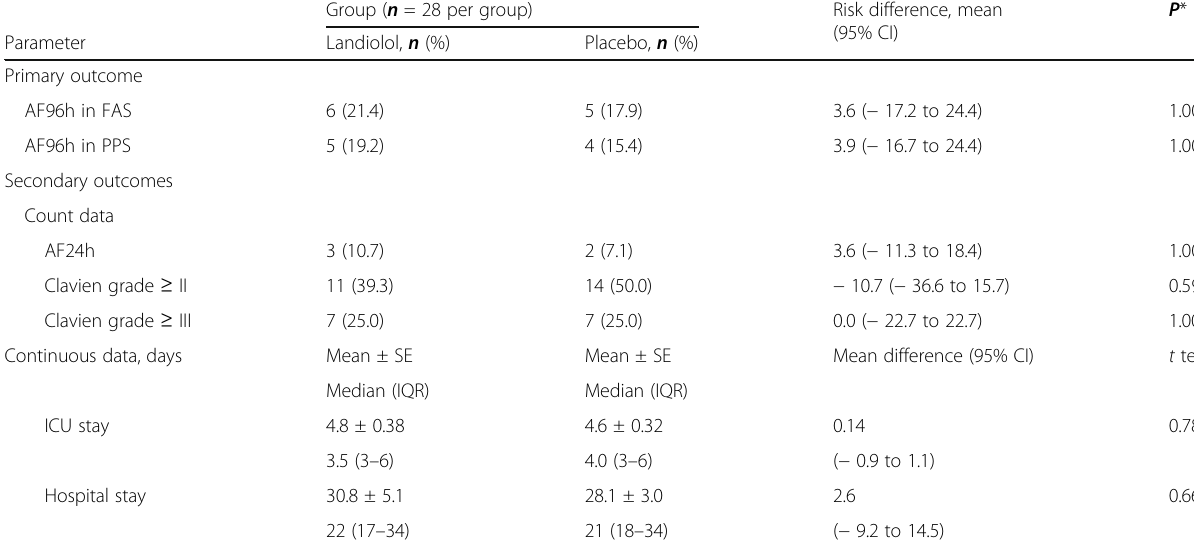
Table 2 Primary and secondary outcomes